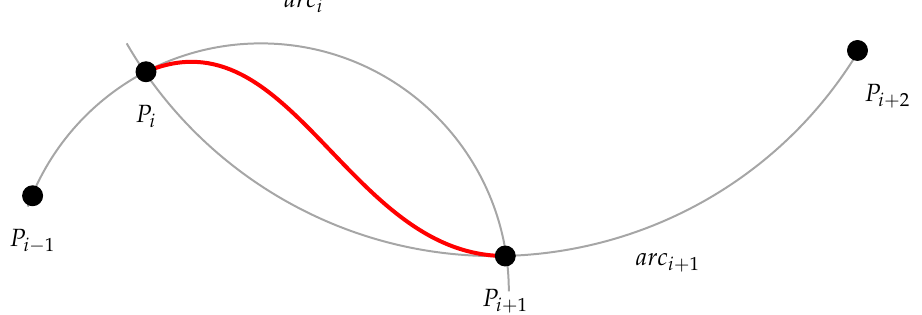
Figure 8. Two arcs blended together to obtain a circle spline (shown as a red